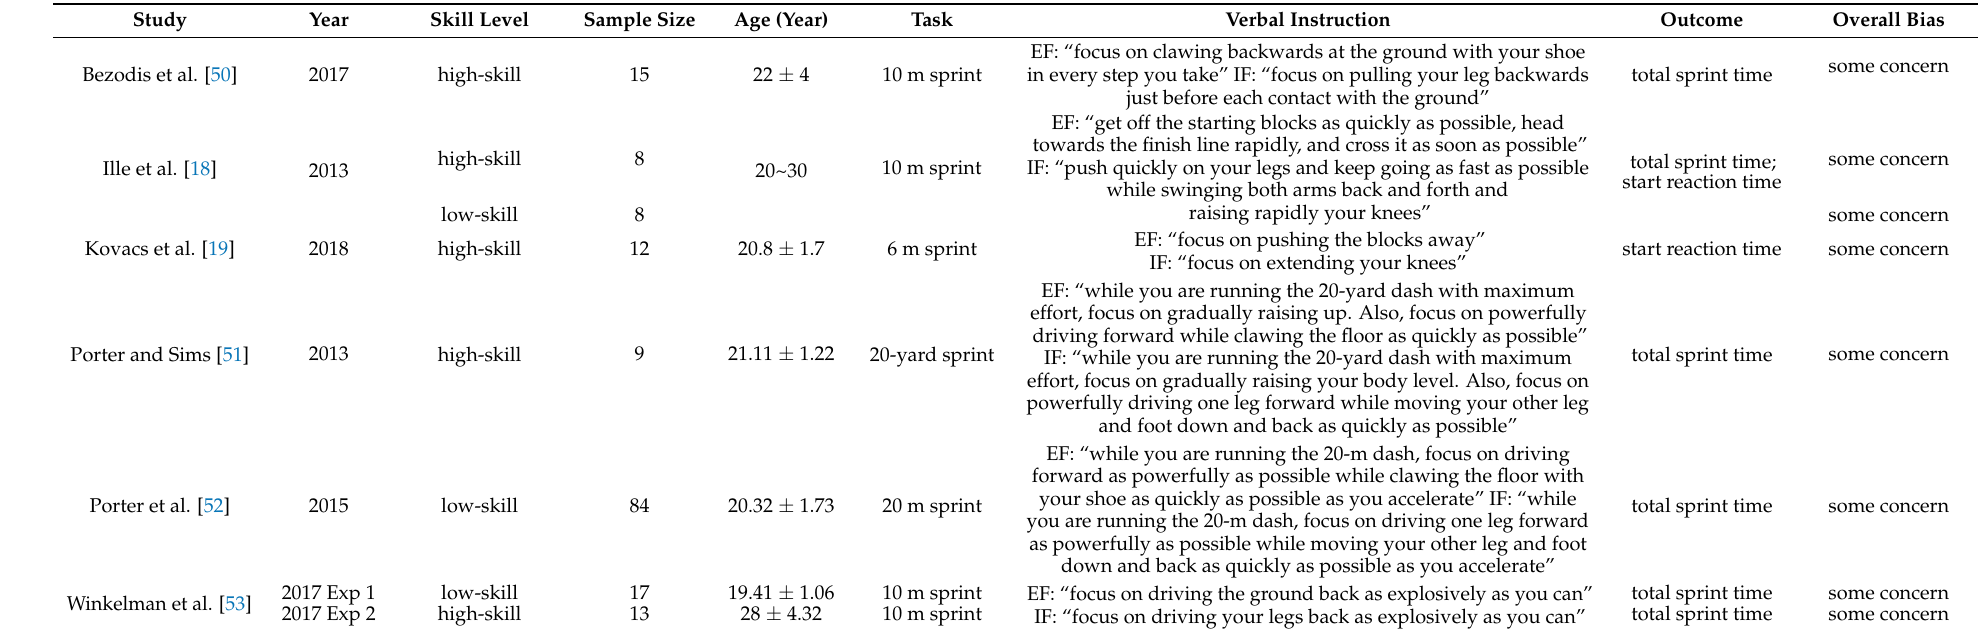
Table 1. Summary of the included studies’